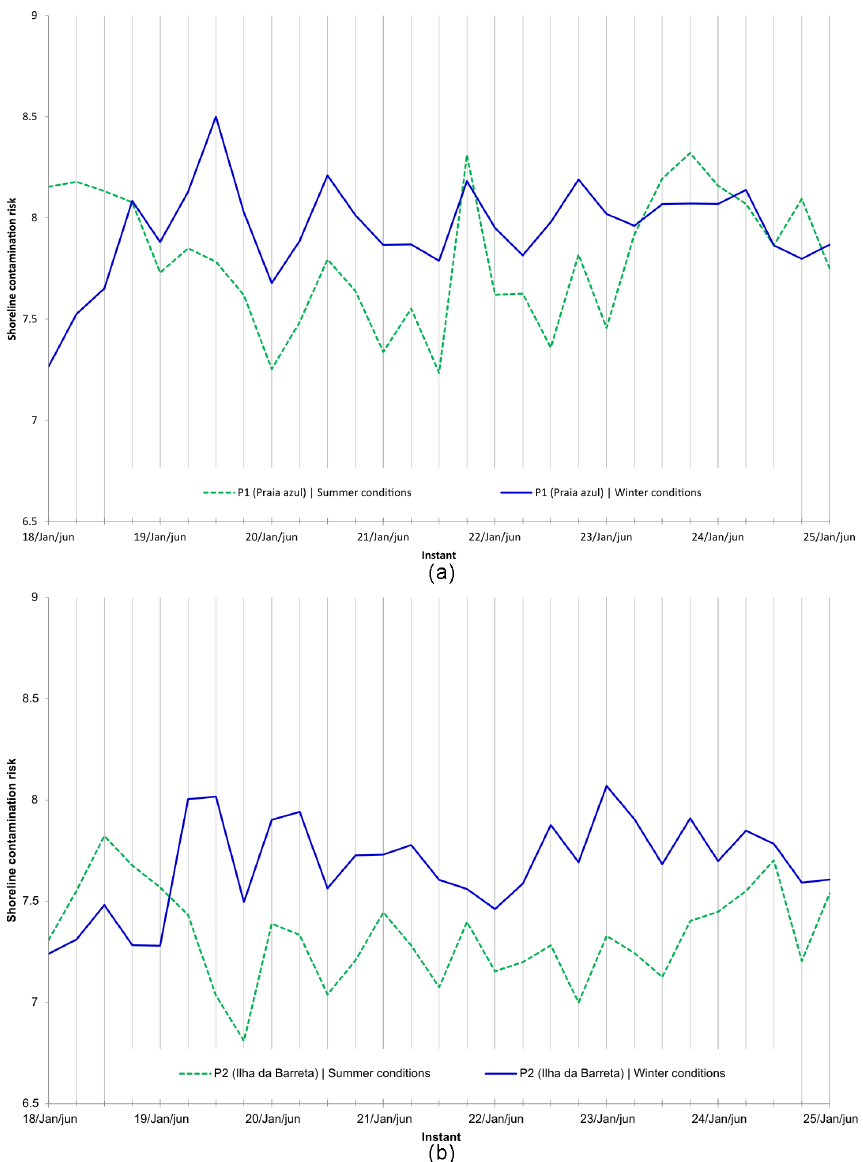
Figure 11. Evolution of shoreline contamination risk at P 1 (a) and P 2 (b) with vessel AIS information obtained between 18 and 25 January, 2013, and using different space and time variable metocean conditions, illustrated in Figs. 9 and